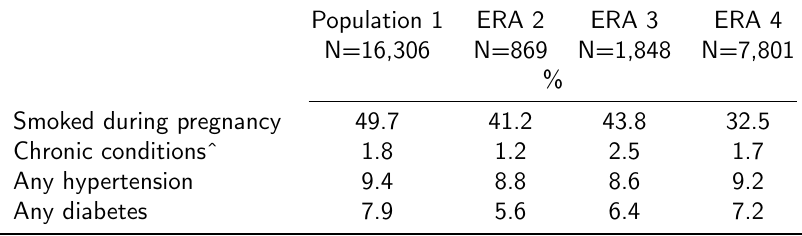
Table 2: Smoking and health status at the time of birth of mothers who were recorded as Aboriginal in the birth data (Population 1) and from an enhanced reporting of Aboriginality algorithm (ERA2 – 4) who gave birth to at least one singleton baby in NSW between 2010 and 2014.